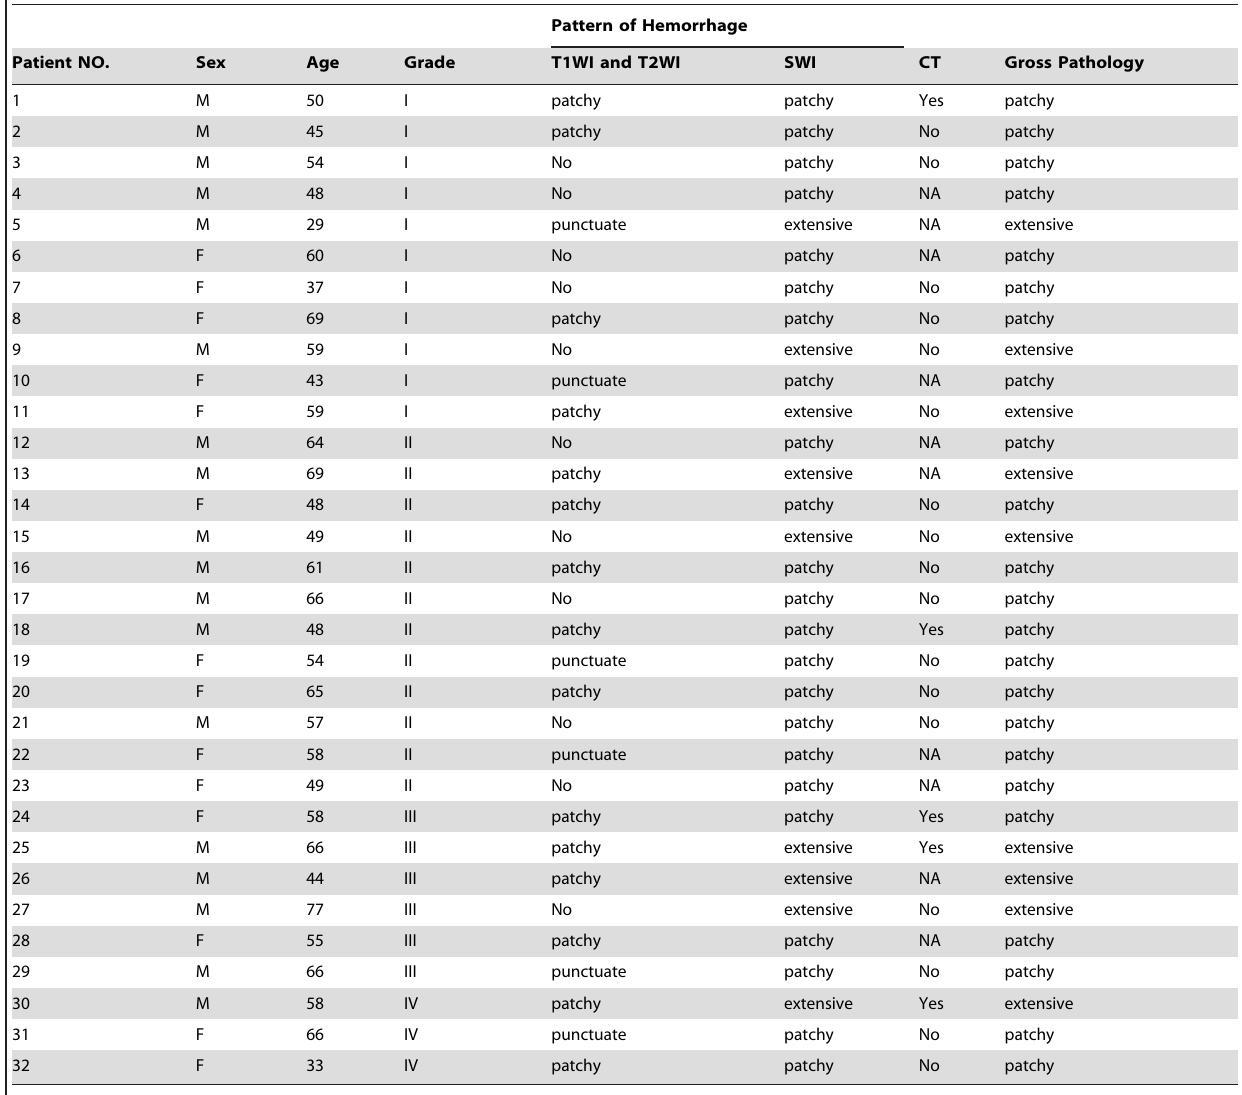
Pattern of Hemorrhage